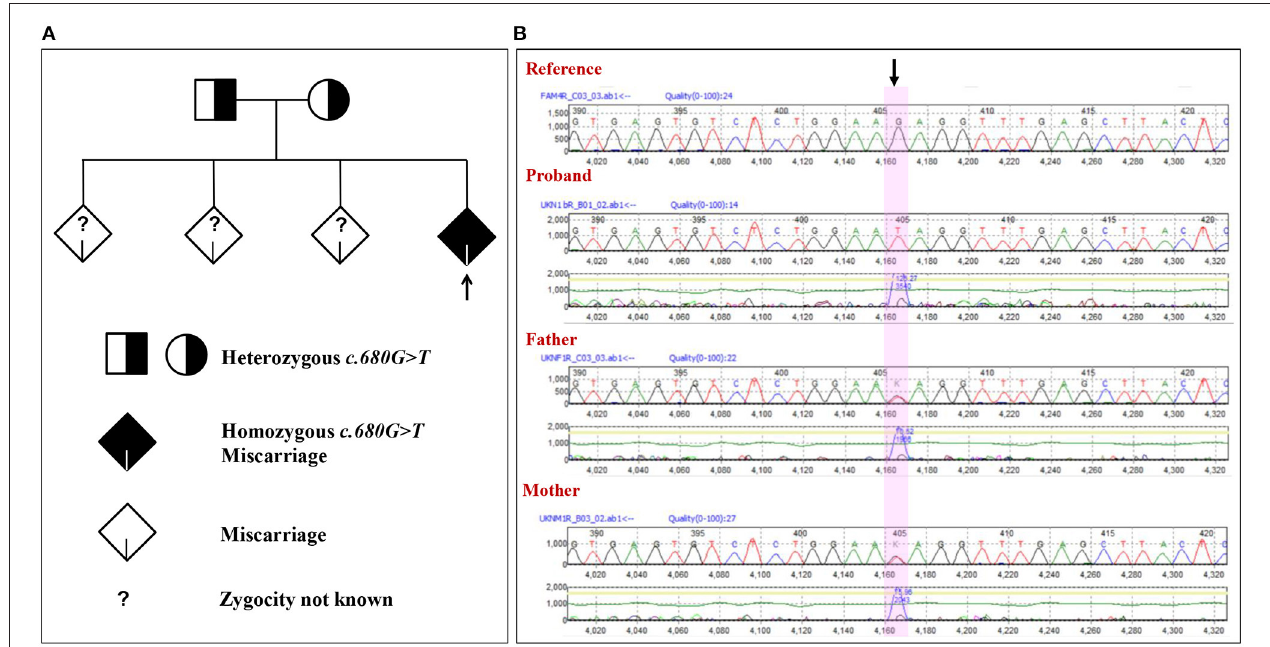
FIGURE 1 | Novel mutation in the ASIC5 gene (NM_017419.3:c.680G > T) in the family. (A) Phylogenic analysis of the family with the NM_017419.3:c.680G > T mutation in the ASIC5 gene. (B) Electropherogram of the sequence c.664 to c.695 of exon 4 at the ASIC5 gene of the proband and the parents. The highlighted nucleotide with arrow indicates the position of the NM_017419.3:c.680G > T. The proband is homozygous for the NM_017419.3:c.680G > T. The mother and father are heterozygous for the NM_017419.3:c.680G >